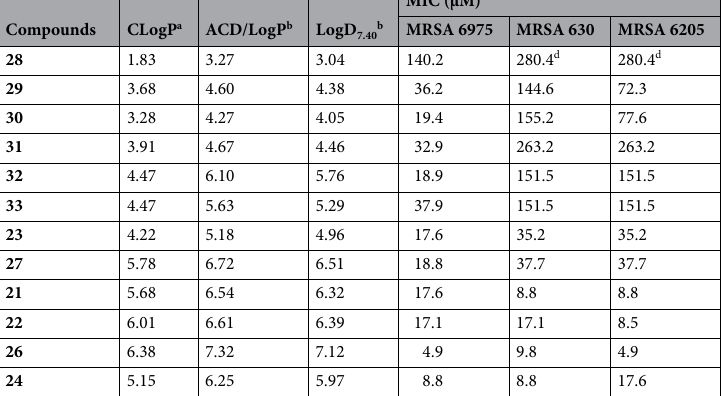
Table 3. Physico-chemical parameters and antimicrobial activities of compounds 21 to 24 , and 26 to 33 12 . a The CLogP values were calculated using software ChemBioDraw Ultra 12.0. b The ACD/Log P and LogD values were calculated using software ACD/Labs 6.0. c MIC, minimum inhibitory concentration; MRSA 6975, methicillin-resistant Staphylococcus aureus 6975; MRSA 630, methicillin-resistant Staphylococcus aureus 630; MRSA 6205, methicillin-resistant Staphylococcus aureus 6205. d The MICs of compound 28 against MRSA 630 and 6205 were more than 64 μg/mL (140.2 μM). As microdilution broth method was used to test MIC and the three physico-chemical parameters were small, we set 128 μg/mL (280.4 μM) as their